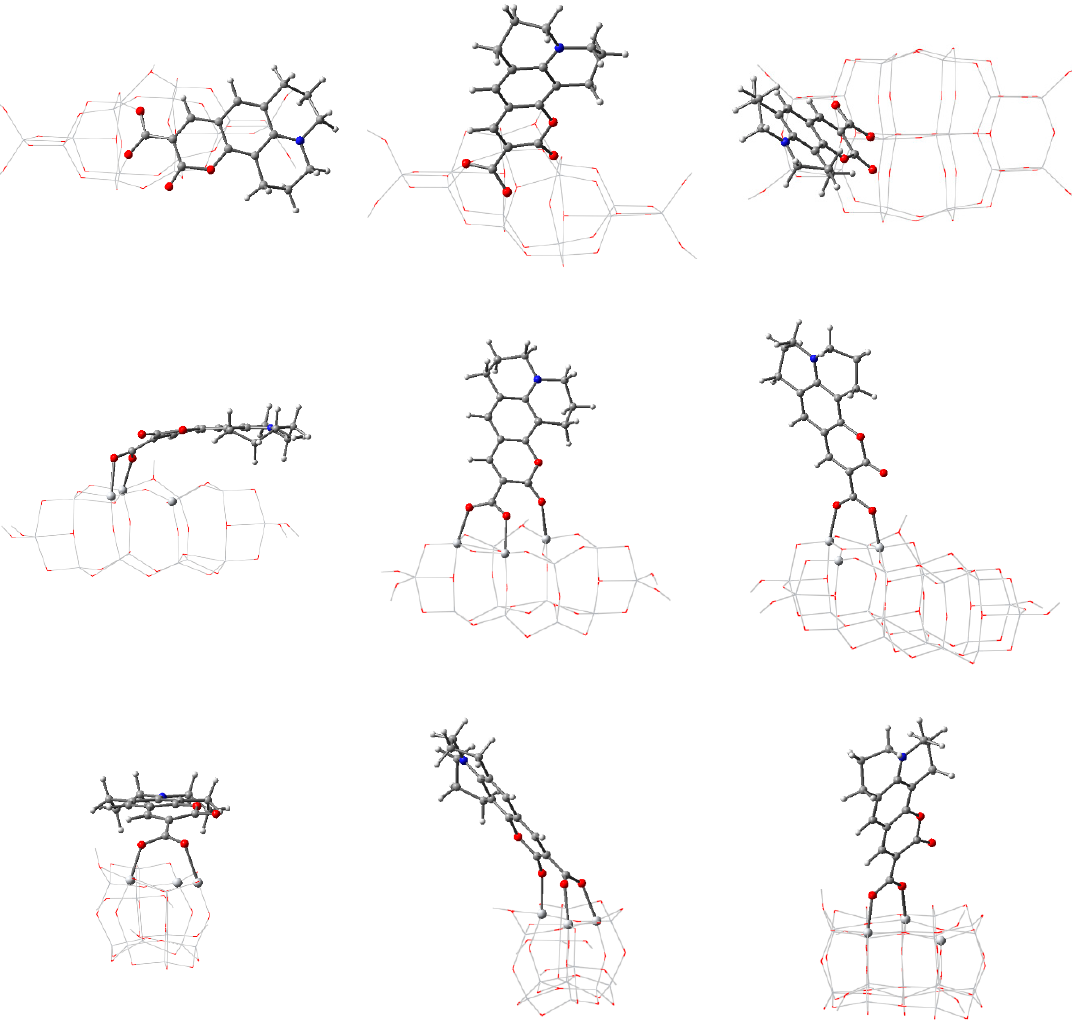
Figure 8. Top ( first row ), side ( second row ), and front ( third row ) views of the optimized structures of the C343 dye molecule adsorbed on the Ti 14 O 30 H 4 cluster ( left and middle column ) and on the Ti 24 O 50 H 4 cluster ( right column ). Calculations performed by DFT at the B3LYP/3-21G(d) level in vacuum. The side and front views also show the three neighbouring Ti atoms to which the molecule can bind. Atom colors are: C, grey; O, red; N, blue; and H, light grey.